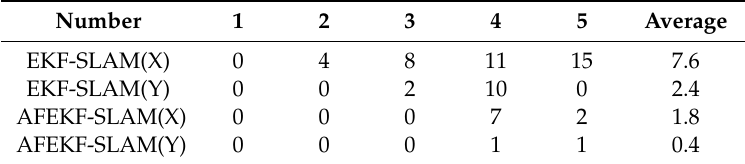
Table 4. Error values of the points related to Table 3 (in meters).